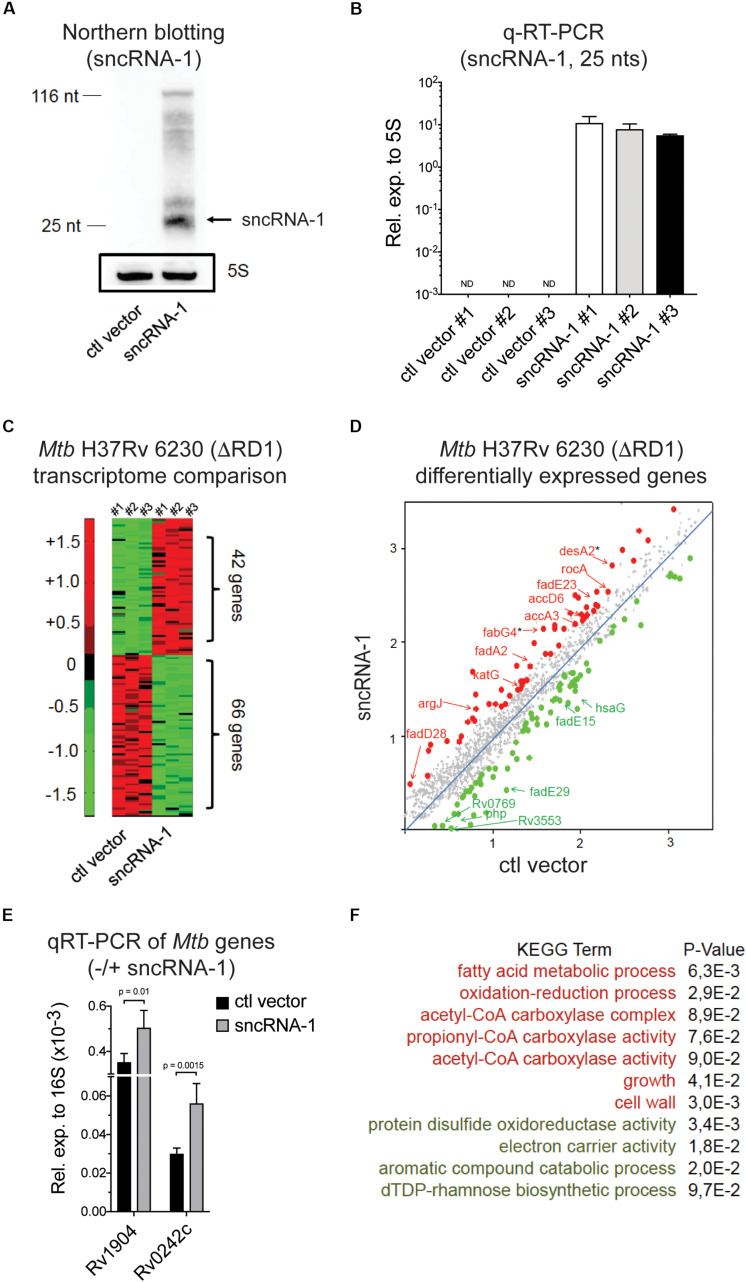
Mtb sncRNA-1 positively regulates the fatty acid metabolism. (A) sncRNA-1 was cloned into the pKA-303 RNA expression vector. The pKA-303-sncRNA-1-hygromycin containing plasmid or the empty vector were electroporated into Mtb H37Rv 6230 (ΔRD1, ΔpanCD) and individual clones were isolated and propagated. RNA was extracted from three clones/group at the stationary phase. sncRNA-1 expression was visualized with Northern blotting using a sncRNA-1 specific probe in clones expressing either the control vector or sncRNA-1 expression vector. A total of 25 nts mature form of sncRNA-1 is indicated with the arrow. The same blot was probed for 5S RNA which is shown in the box. Shown is a representative image of three clones. (B) sncRNA-1 was quantified using miRCURY LNATM quantitative miRNA PCR system relative to mycobacterial 5S rRNA. (C) RNA was extracted from the indicated clones and used for RNA Seq. A representative heat map, using a 1.5-fold differential expression cutoff, illustrates the differential gene expression (red = elevated expression; green = low expression). (D) Differentially regulated bacterial transcripts are shown. Ones highlighted with a star are those identified as putative sncRNA-1 targets. (E) These putative targets were quantified in Mtb H37Rv 6230 clones expressing either the ctl vector or the sncRNA-1 expression vector with qRT-PCR relative to 16S rRNA. (F) Using significantly up/down regulated genes in DAVID 6.8, KEGG GO term analysis was performed. Pathways for which p < 0.1 are shown.